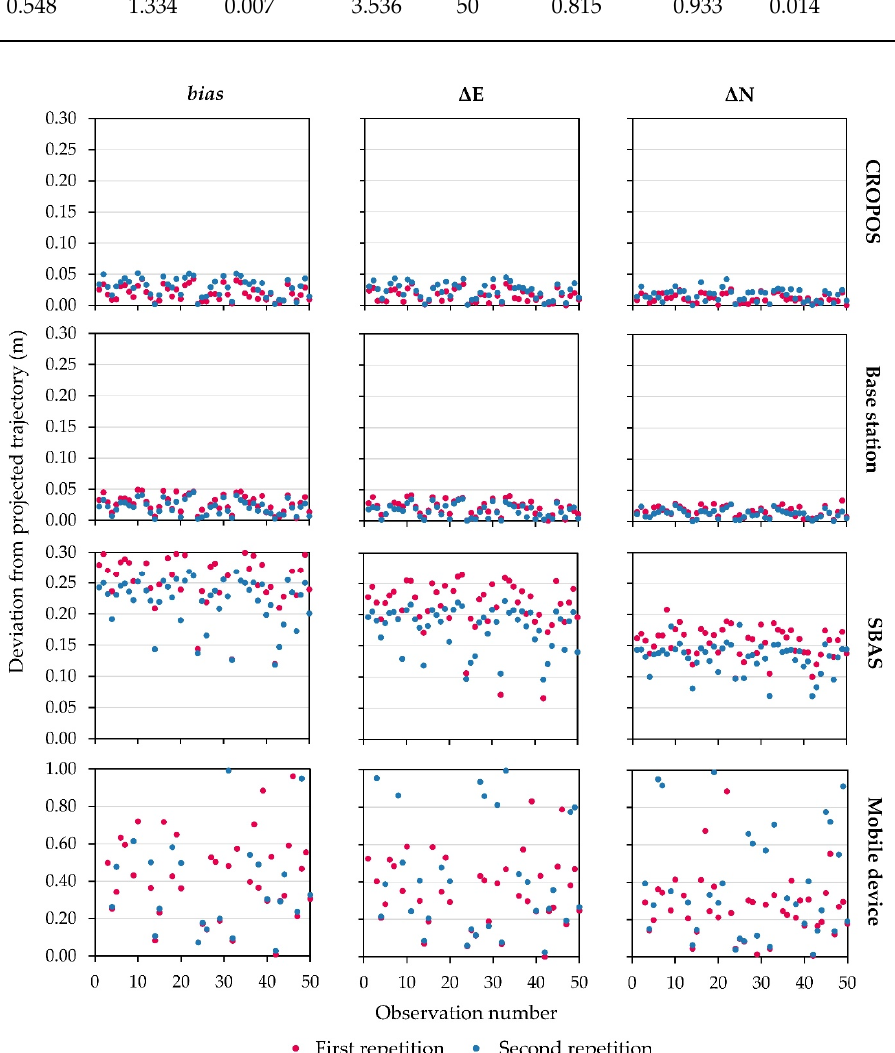
Figure 5. A comparative visual representation of deviations from the projected trajectory for four tested GNSS positioning variants. The null hypothesis of the Shapiro-Wilk test was rejected for all tested samples, indi- cating that neither pair of samples observed with the same GNSS correction possessed a normal distribution of values (Table 3). Accordingly, a non-parametric Wilcoxon statisti- cal test was selected for the evaluation of all GNSS observation samples.